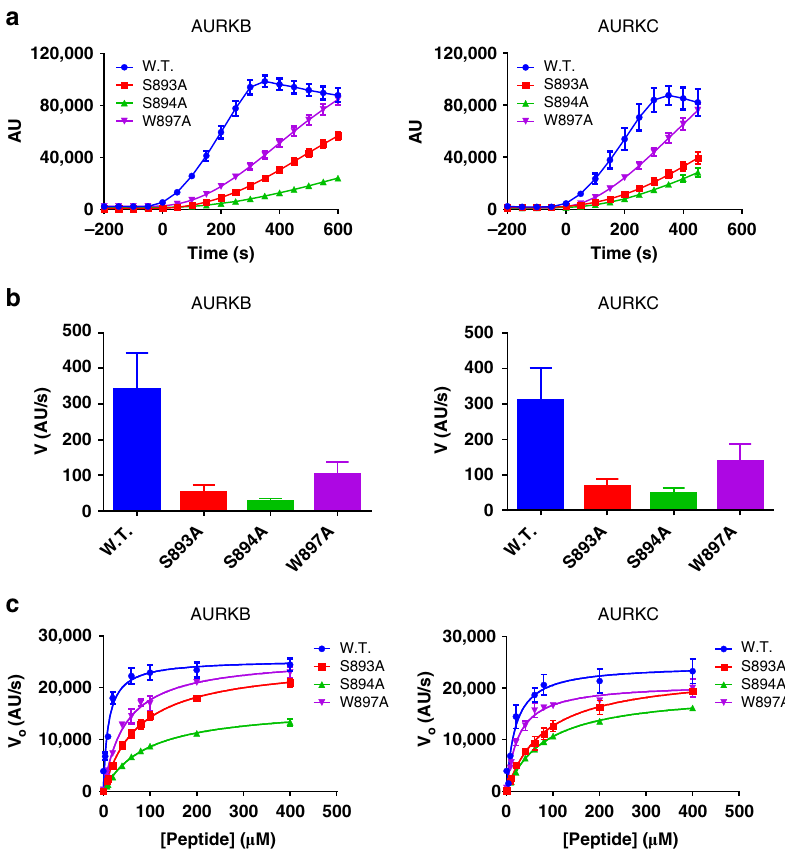
Fig. 2 Enzymatic assays of AURKB or AURKC with wild-type or mutant INCENP. Mutation of the INCENP phosphorylation sites Ser893 or Ser894, or of INCENP Trp897 which is also important for Aurora kinase:INCENP binding, altered the enzymatic properties considerably. All measurements were made in triplicate. a Loss of TSS motif binding decreases the reaction rate for both AURKB and AURKC on a peptide substrate. b Quanti fi cation of the rate of reaction during the linear reaction phase of a . Error bars show standard error from the linear regression. c Measurement of initial rate of reaction (V 0 ) at varying peptide substrate concentrations, with curves calculated by non-linear regression (curve- fi tting) to the Michaelis – Menten equation. Calculated K M and K cat values from non-linear regression are shown in Table 2; the mutants show signi fi cant variation in K M but similar K cat values (with the possible exception of S894A)